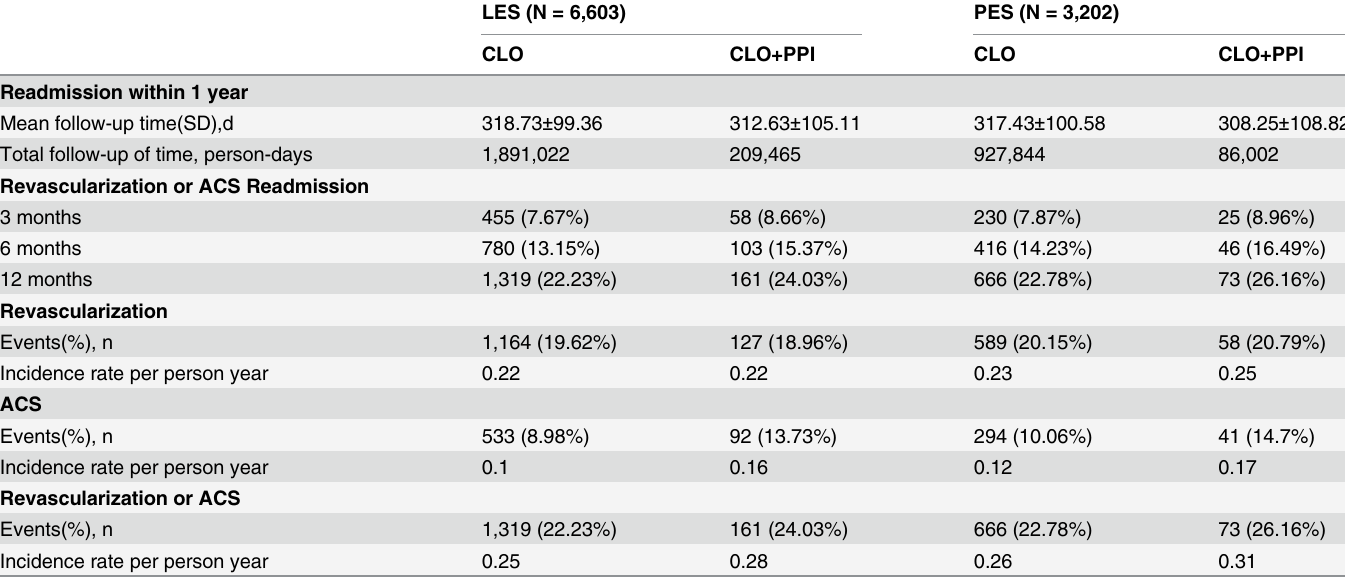
Table 2. Patients follow-up, events, and incidence rate in patients with type 2 DM after DES implantation.